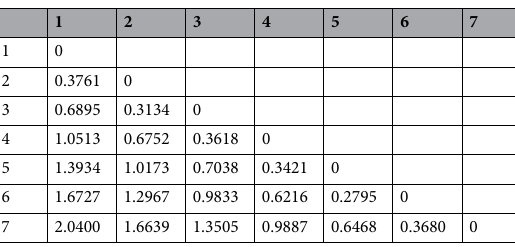
Table 3. Baseline lengths calculated from shooting positions (meters).